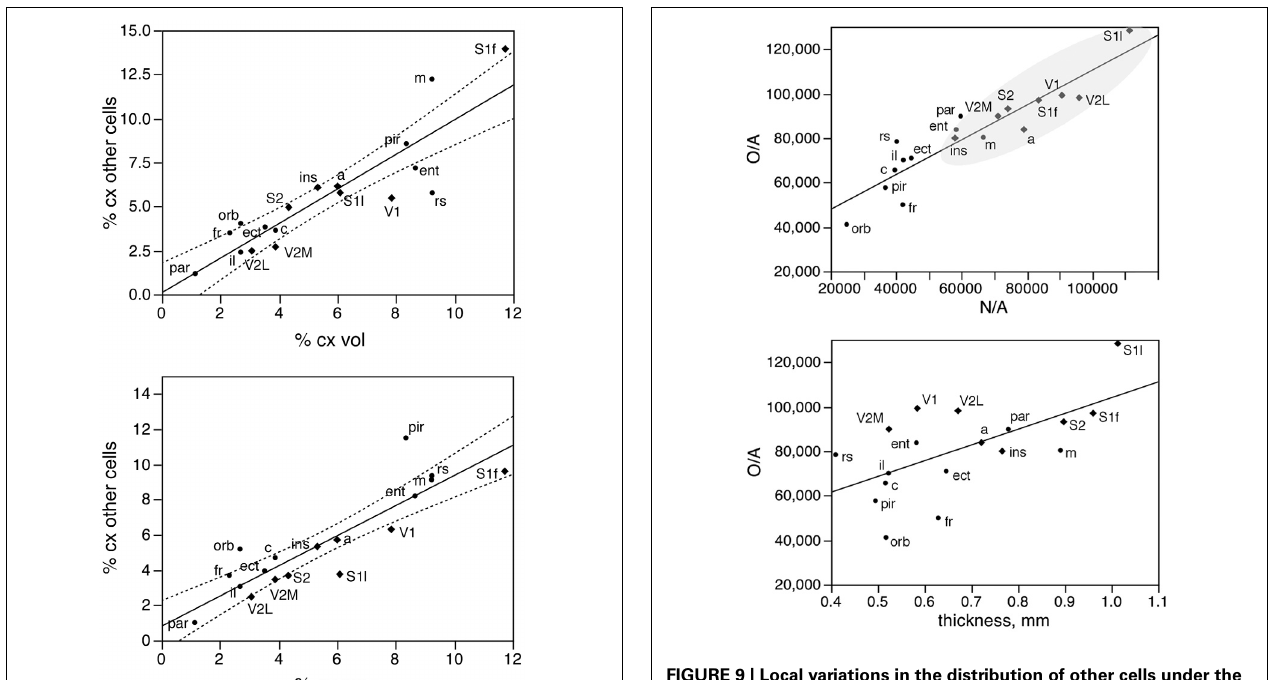
FIGURE 9 | Local variations in the distribution of other cells under the cortical surface (O/A) are tightly linked to local variations in the distribution of neurons under the cortical surface (N/A) but not to variations in cortical thickness. Top, other cells per mm 2 of cortical surface (O/A) in each area plotted as a function of the number of neurons per mm 2 in the same area (N/A). Bottom, other cells per mm 2 of cortical surface (O/A) in each area plotted as a function of thickness of the grey matter in the same area. The fitted lines are the linear functions that describe the entire